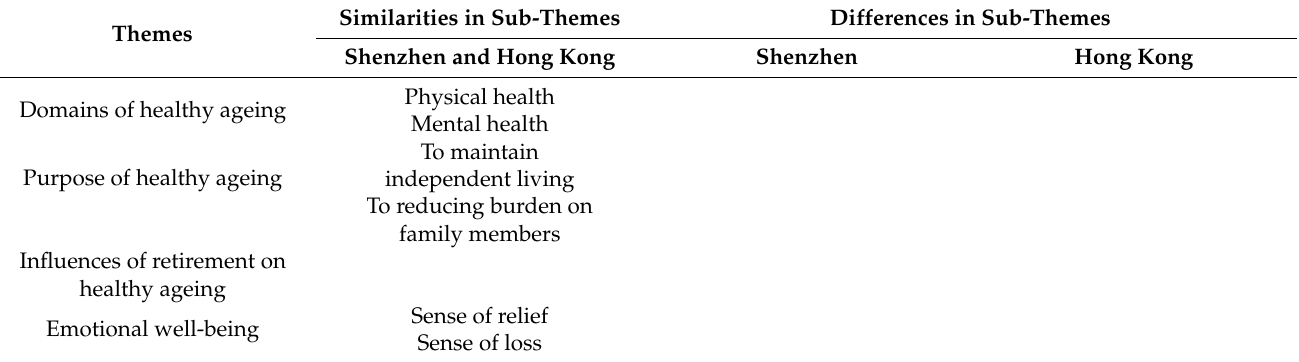
Table 2. Summaries of